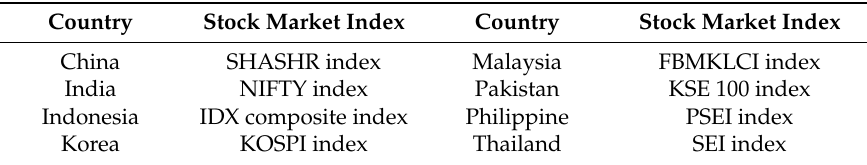
Table 1. Description of